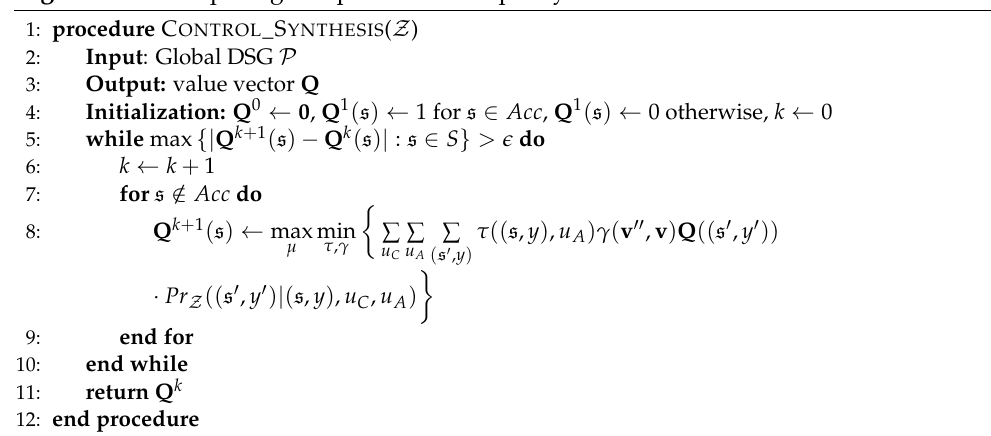
Algorithm 5 Computing an optimal control